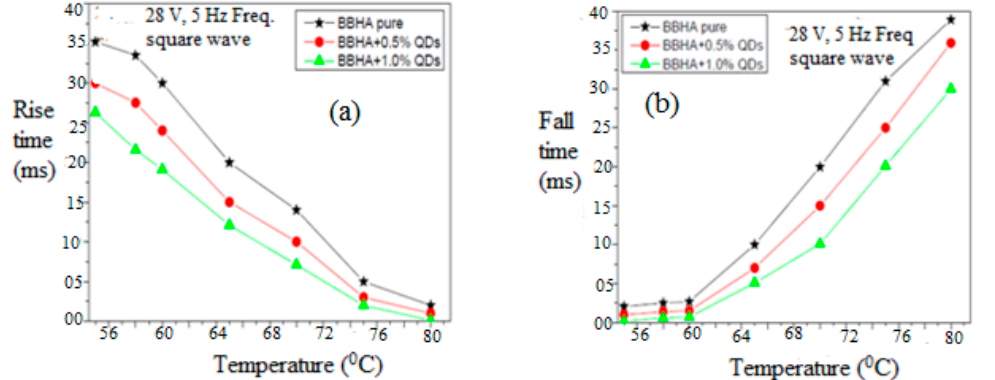
Figure 9. Variation of ( a ) rise time and ( b ) fall time of pristine and QDs (size 8.2 nm) dispersed nematic BBHA at fixed applied voltage with temperature and QDs concentration [16].